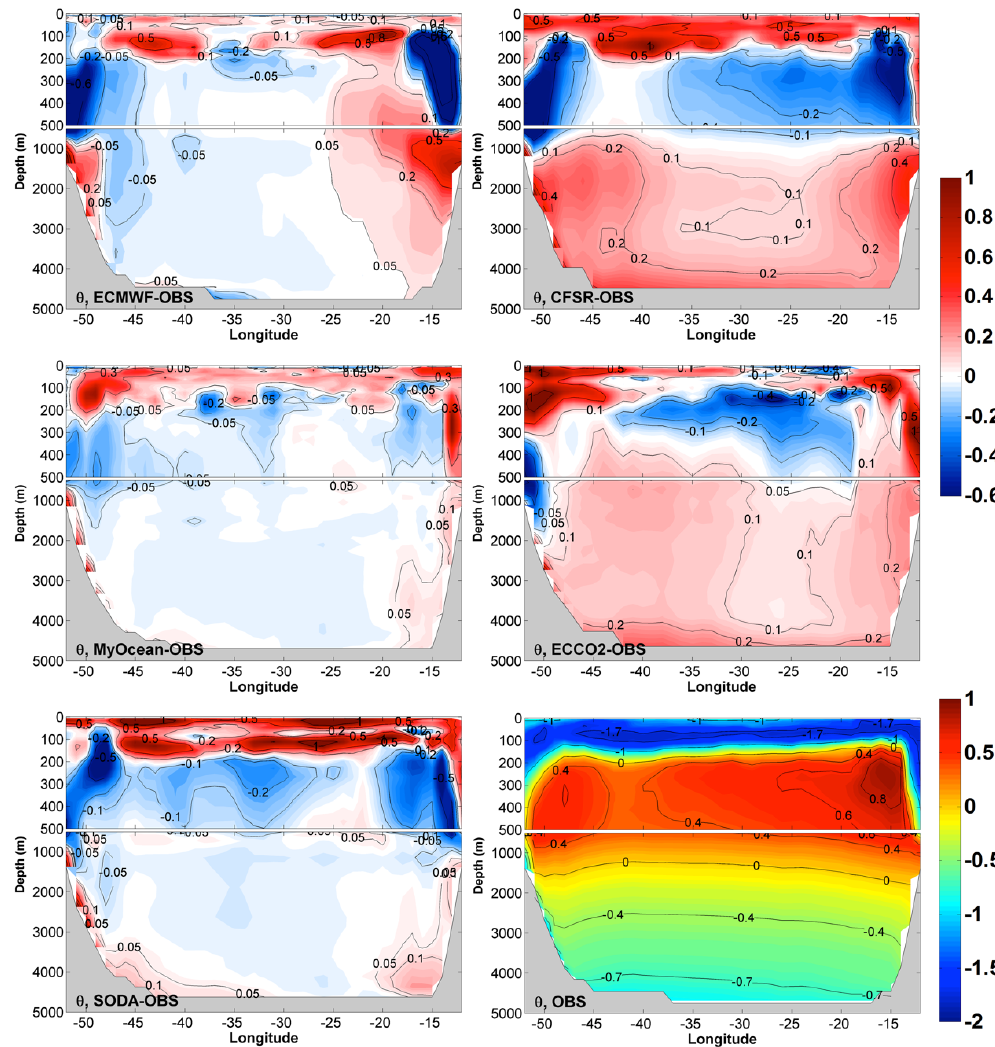
Figure 5. Same as in Fig. 4, but for section WOCE SR4.